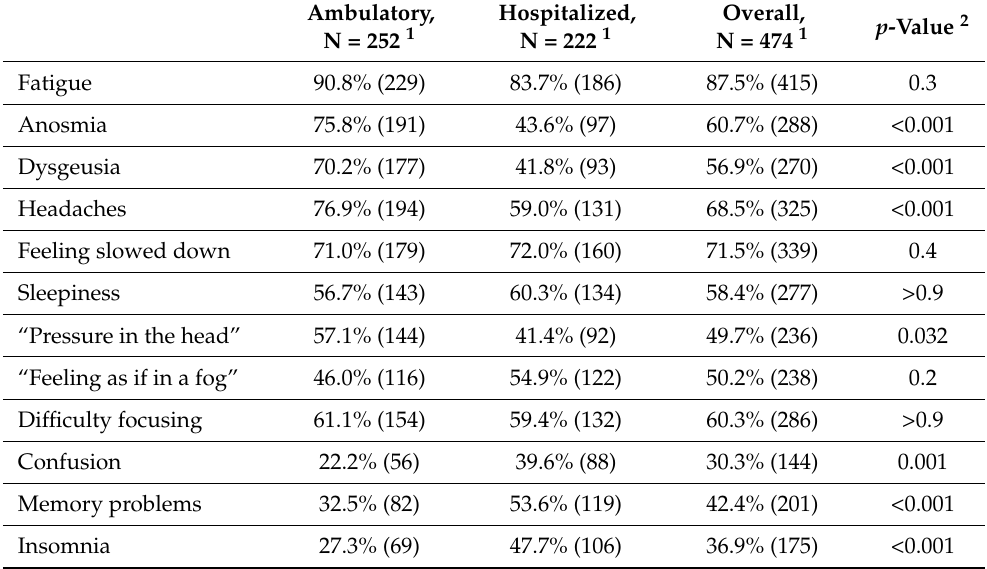
Figure 2. Delta score measuring the improvement of neurological variables between COVID occur- rence and 1-year follow-up. Each variable is treated as a difference of median. Values are compared using Wilcoxon rank sum test. * p < 0.05, ** p < 0.001. Table 4. Neurological symptoms at COVID occurrence.